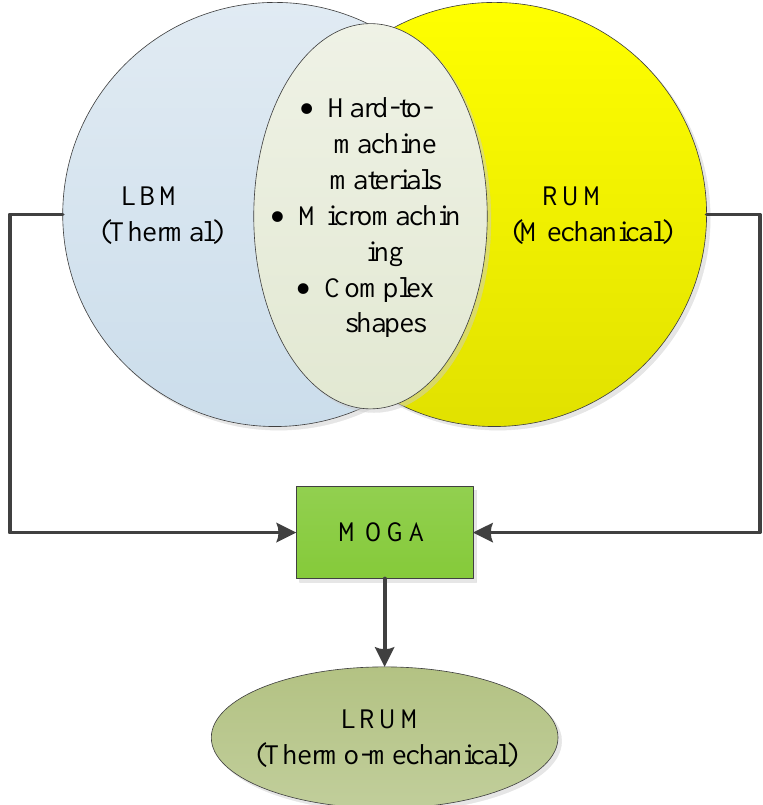
Figure 1. Unification of laser beam machining (LBM), rotary ultrasonic machining (RUM), and laser rotary ultrasonic machining (LRUM) processes.